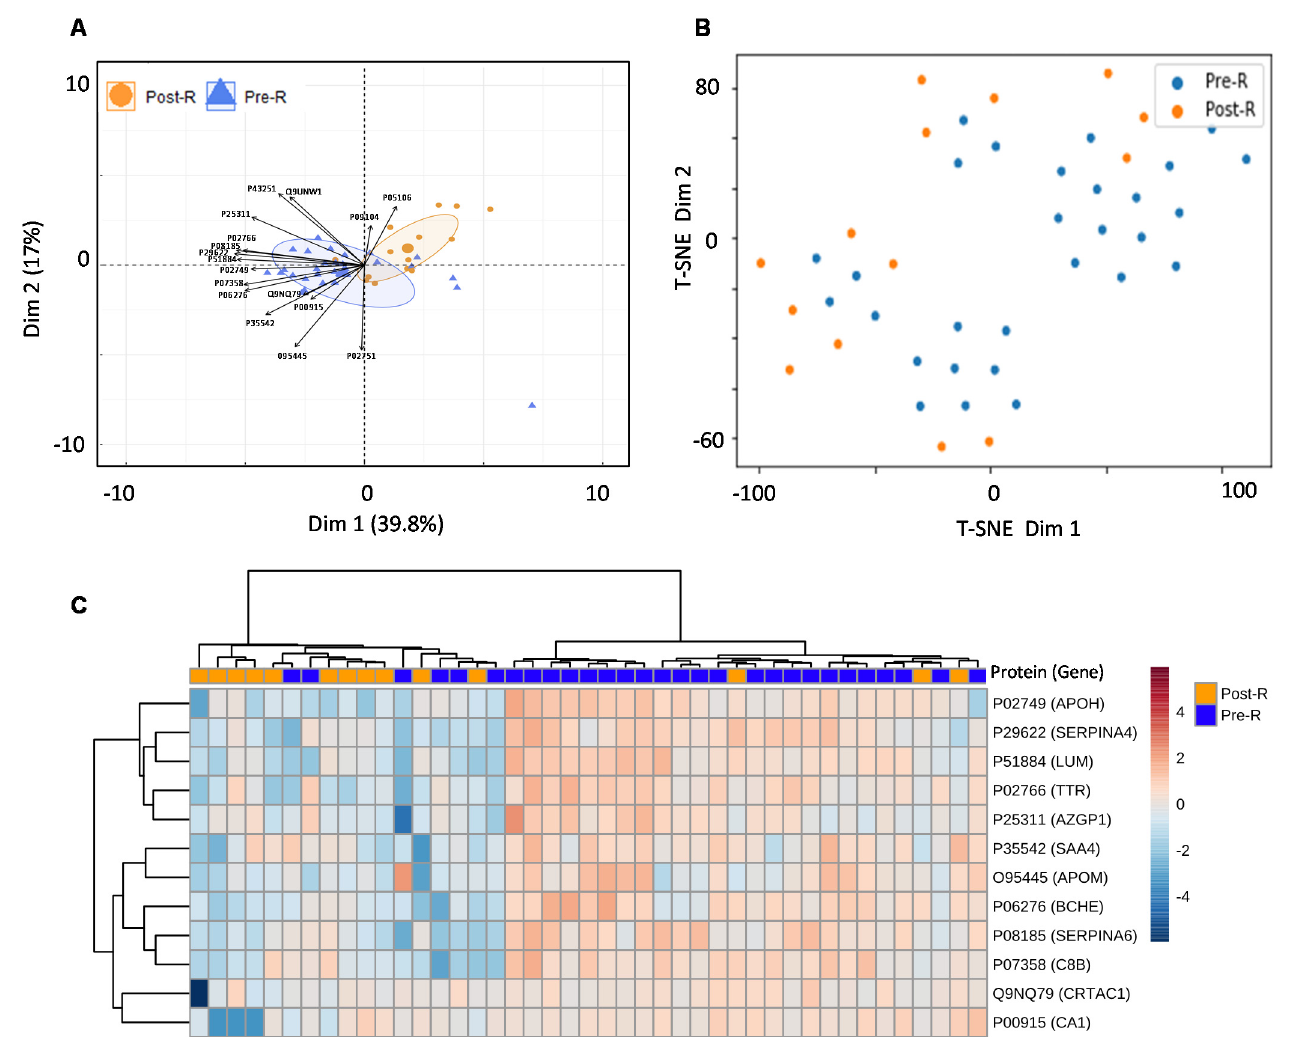
Figure 6. Usability of the combined PCa serum library. ( A ) PCA showing separation between pre- and post-radiotherapy samples of validation cohort after feature selection by random forest. ( B ) t-SNE plot showing separation between pre- and post-radiotherapy samples in the validation cohort after feature selection by random forest. ( C ) Heatmap showing the clustering of pre- and post-radiotherapy samples based on significant ( p value ≤ 0.05) and non-variable proteins. Each coloured cell on the map represents a data point's concentration value, with samples arranged in rows and features arranged in columns. Distance was calculated using the "Euclidean" approach, while clustering was performed using the "ward" method. The Uniprot accession number of each given protein are as follows: APOM (O95445), TTR (P02766), APOH (P02749), SAA4 (P35542), CA1 (P00915), ITGB3 (P05106), SERPINA6 (P08185), BCHE (P06276), SERPINA4 (P29622), C8B (P07358), LUM (P51884), CRTAC1 (Q9NQ79), AZGP1 (P25311), FN1 (P02751), ENO2 (P09104), MINPP1 (Q9UNW1) and BTD (P43251).